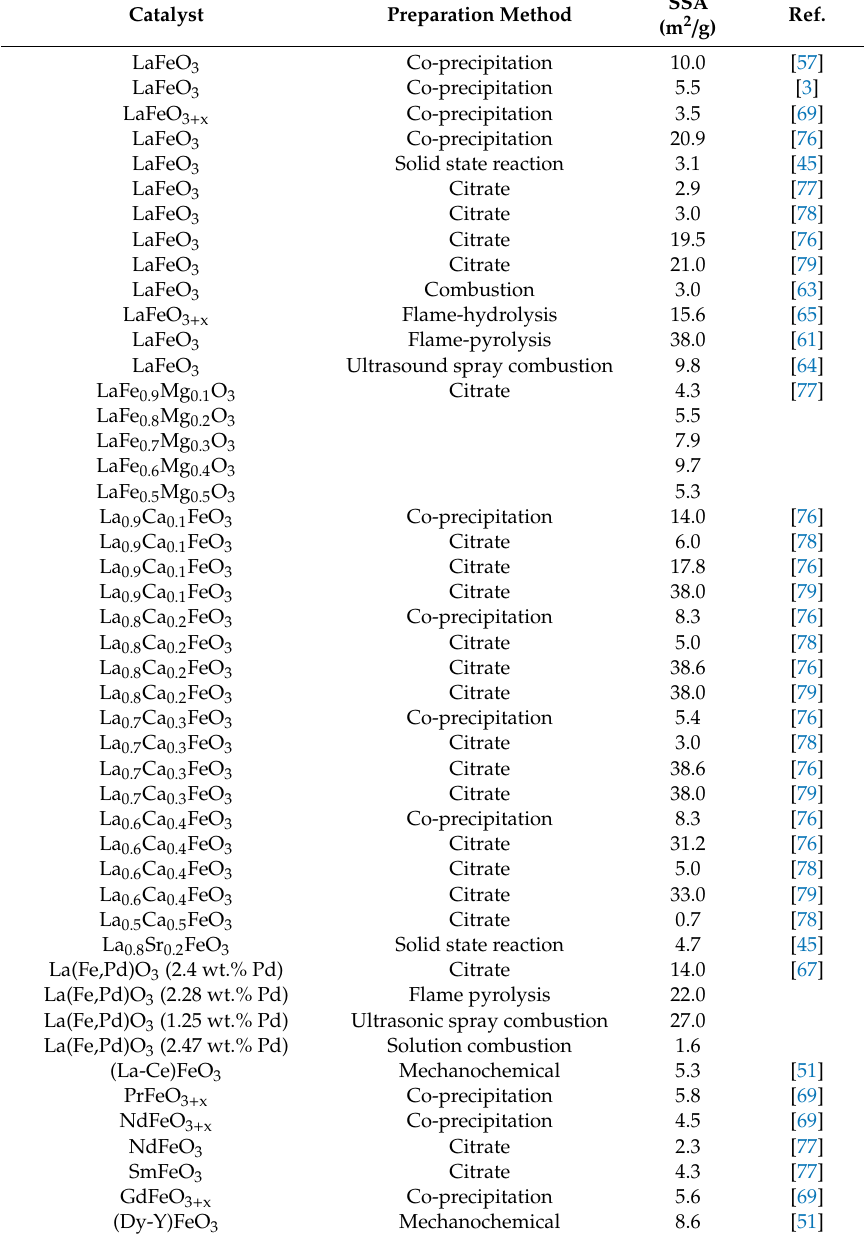
Table 4. The influence of the synthesis method on the specific surface area of lanthanide ferrite-based perovskite